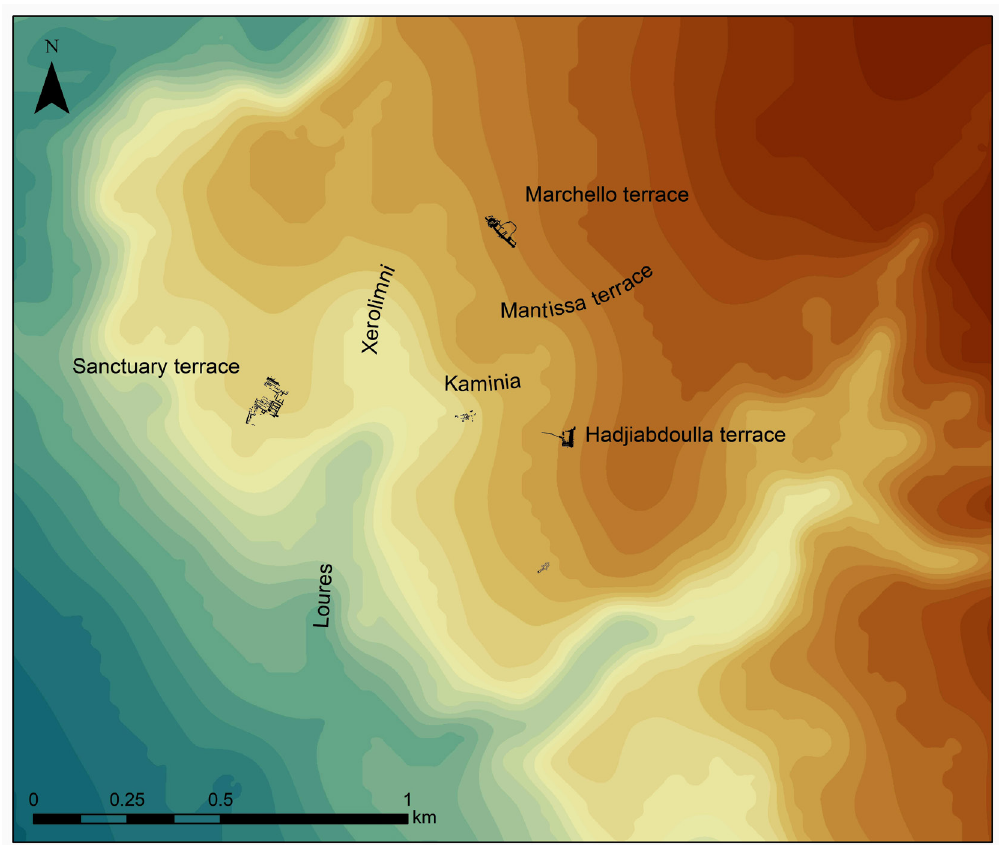
Figure 12. Digital Elevation Model with the plateaus (terraces) of the Palaepaphos urban landscape and the Loures streambed. Contour interval: 5m. Drafted by A. Agapiou